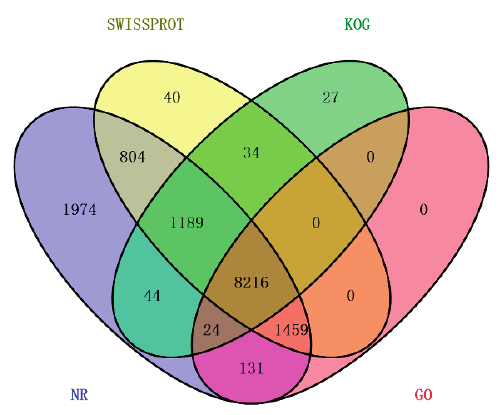
Figure 3. Comparison of the number of unigene annotations obtained from the different databases. Each section illustrates the number of unigenes shared among the Nr, Swiss-Prot, KOG and GO databases.